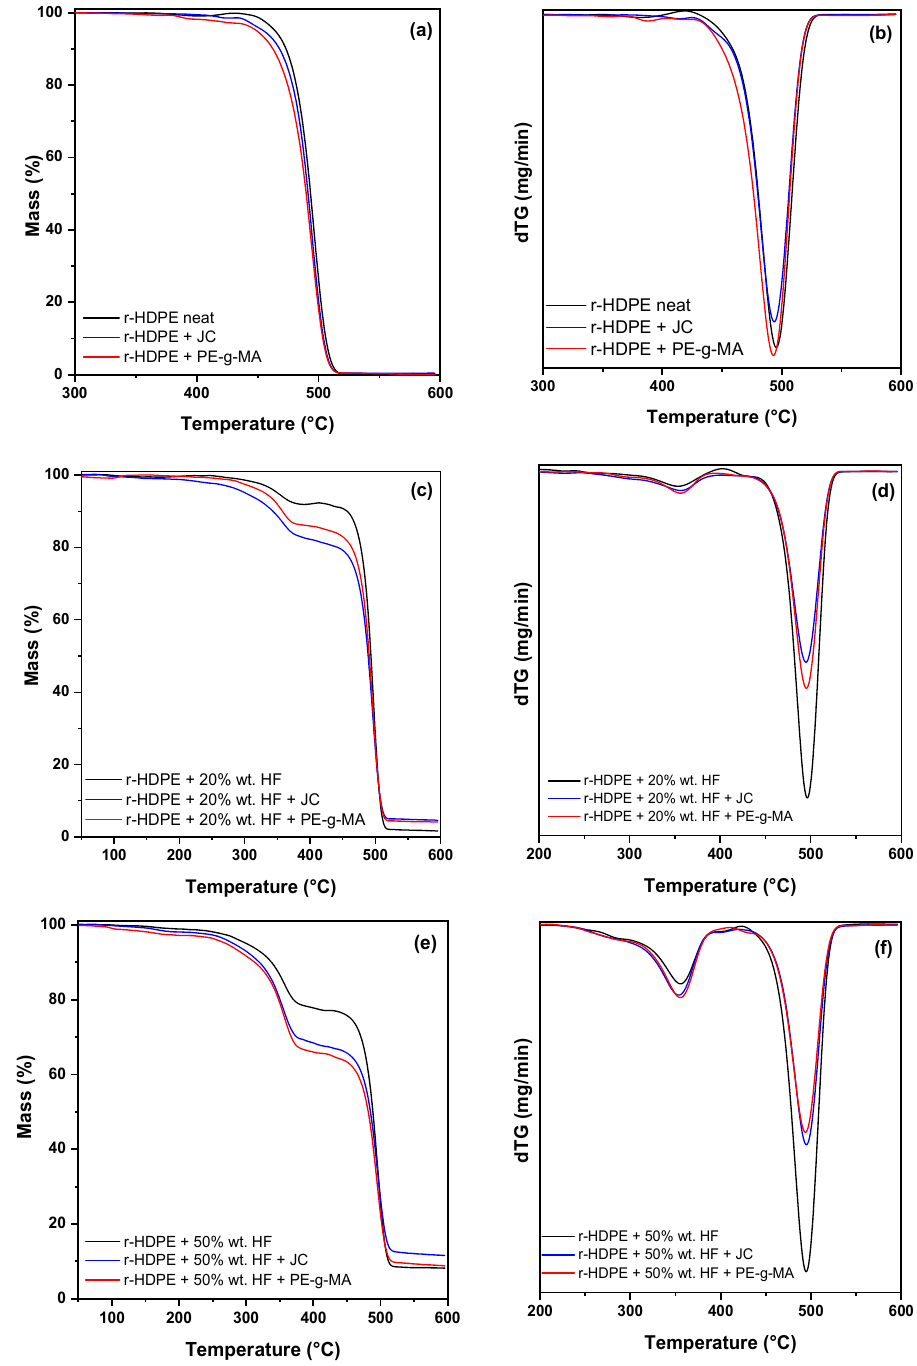
Figure 6. Comparative thermograms of the mass loss and the derivative of the mass loss of ( a , b ) recycled high-density polyethylene (r-HDPE), ( c , d ) r-HDPE + 20% wt. hemp fibers (HF), and ( e , f ) and 50% wt. HF.